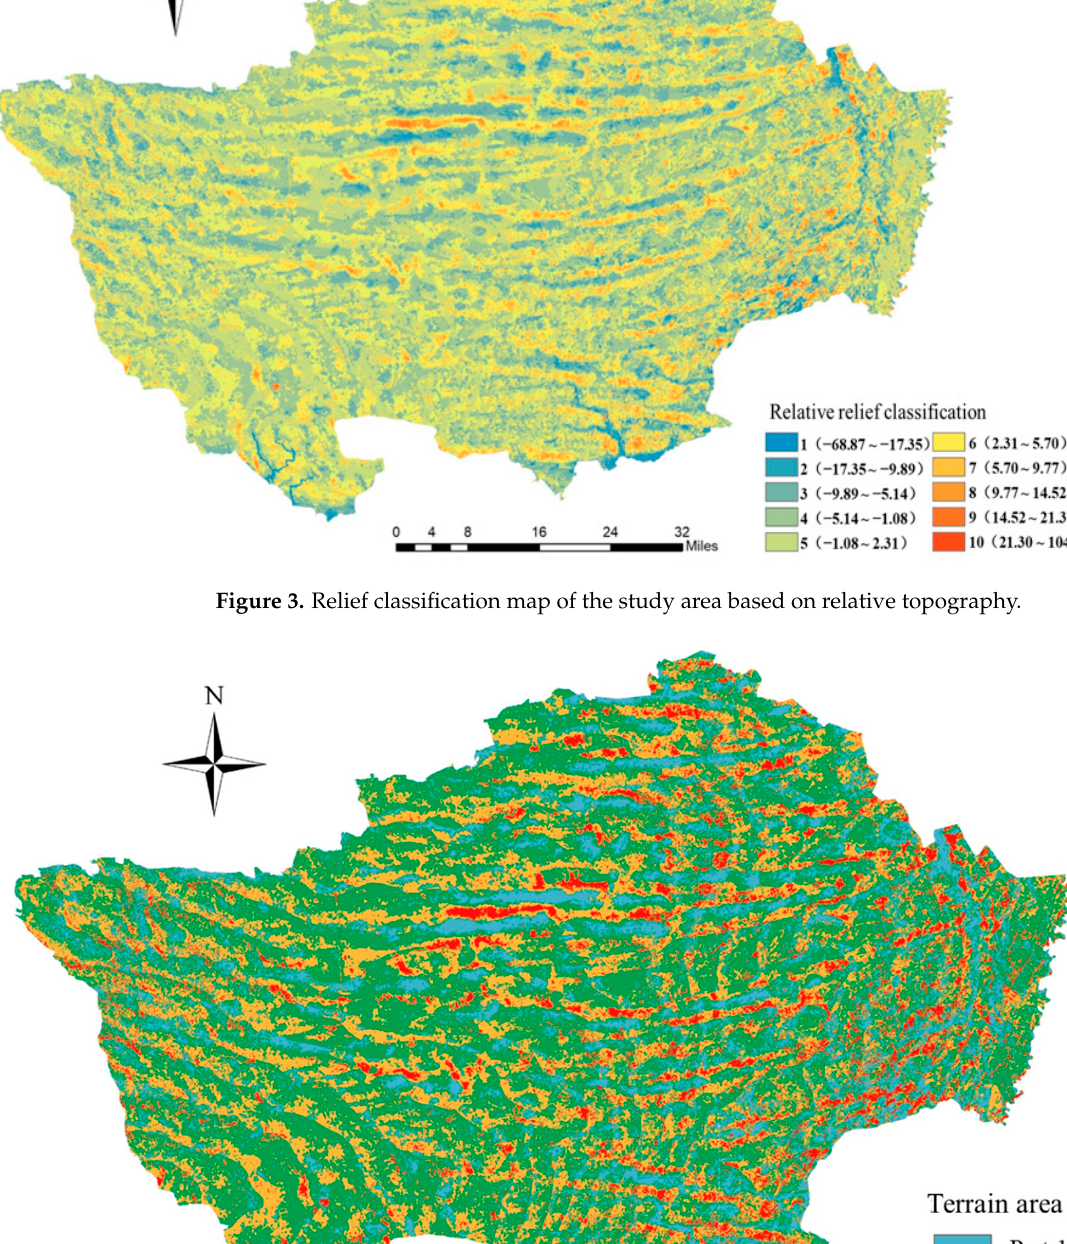
Figure 5. Spatial distribution patterns of irrigated and rainfed agricultural land in the semi-arid sandy region. 4. Discussion Land use in semi-arid sandy areas is restricted by water resources. If the intensity of land use is too small, the needs of local residents for survival and development cannot be